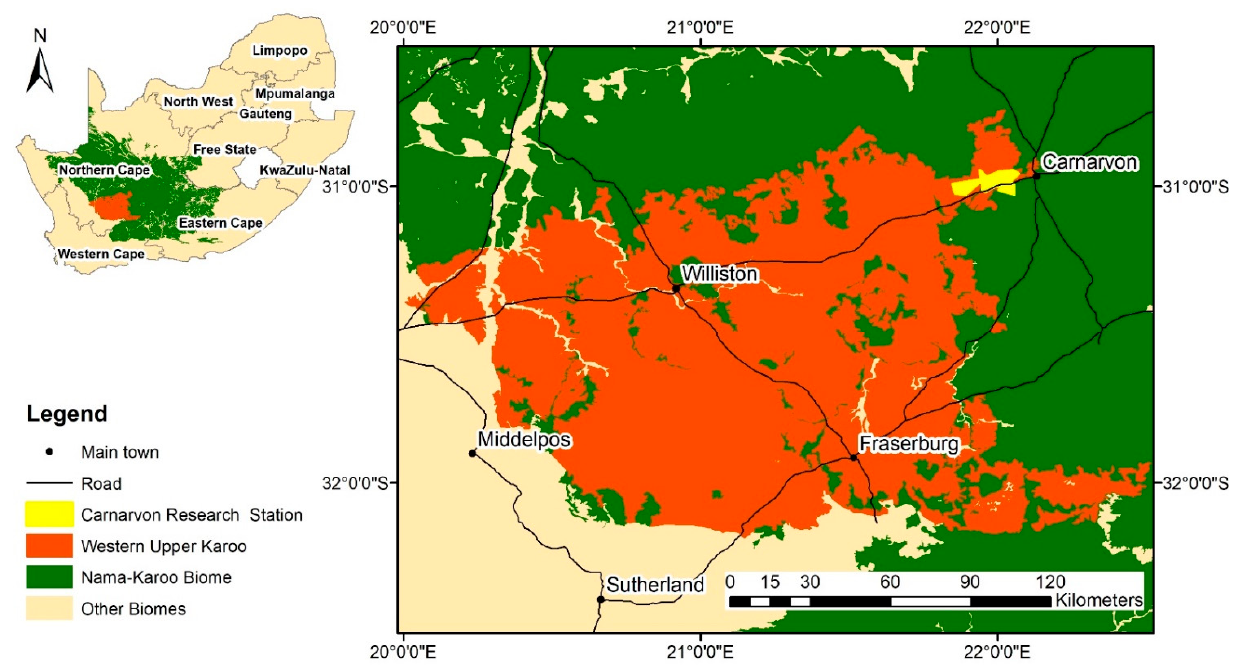
Figure 1. Location of the Western Upper Karoo region within the Nama-Karoo biome. Insert map shows the location within South Africa. The Carnarvon research station is indicated in yellow; the Nama-Karoo biome is indicated in green and the Western Upper Karoo vegetation type is indicated in orange.